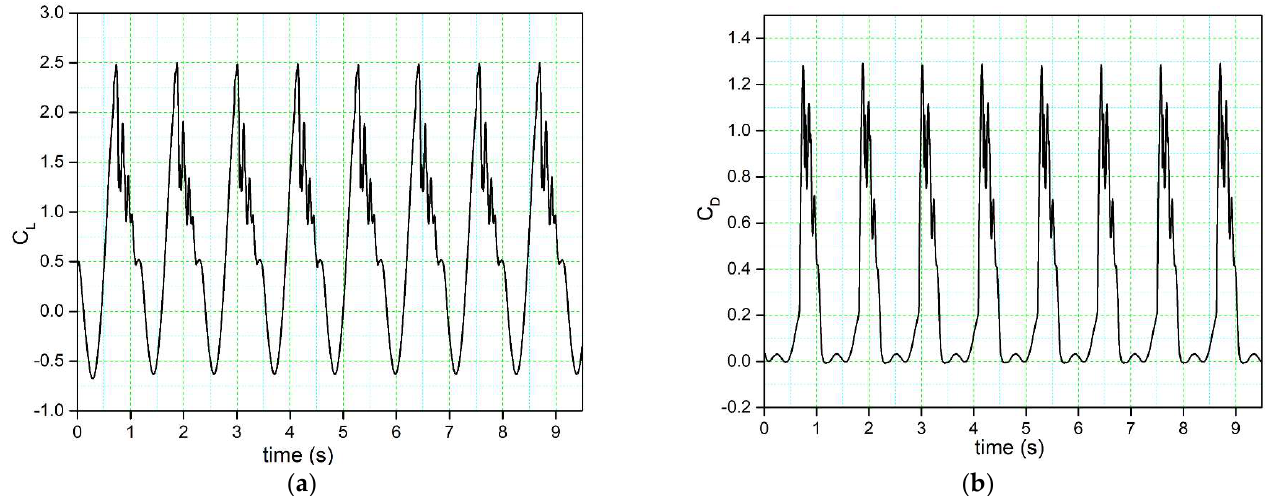
Figure 4. Time history of the ( a ) lift coefficient and ( b ) the drag coefficient.